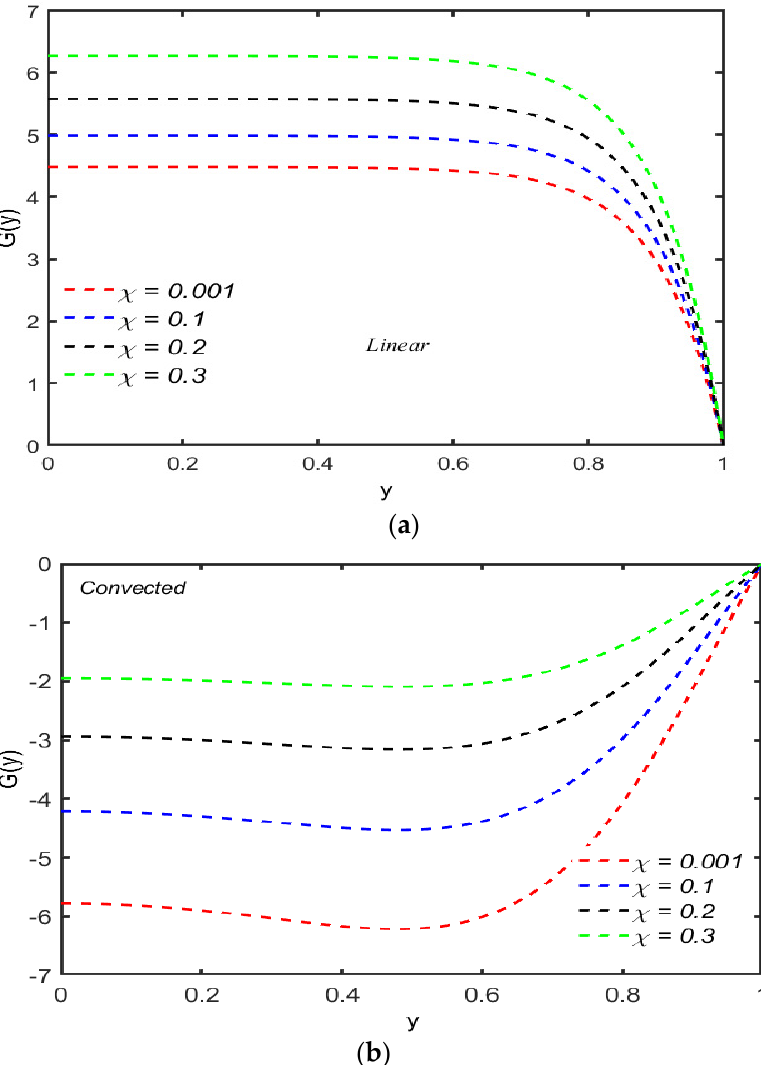
Figure 3. ( a ) Change in G ( y ) for χ with R = 100, α = 0.5, λ 1 = 0.5. ( b ) Change in G ( y ) for χ with R = 100, α = 0.5, λ 1 =